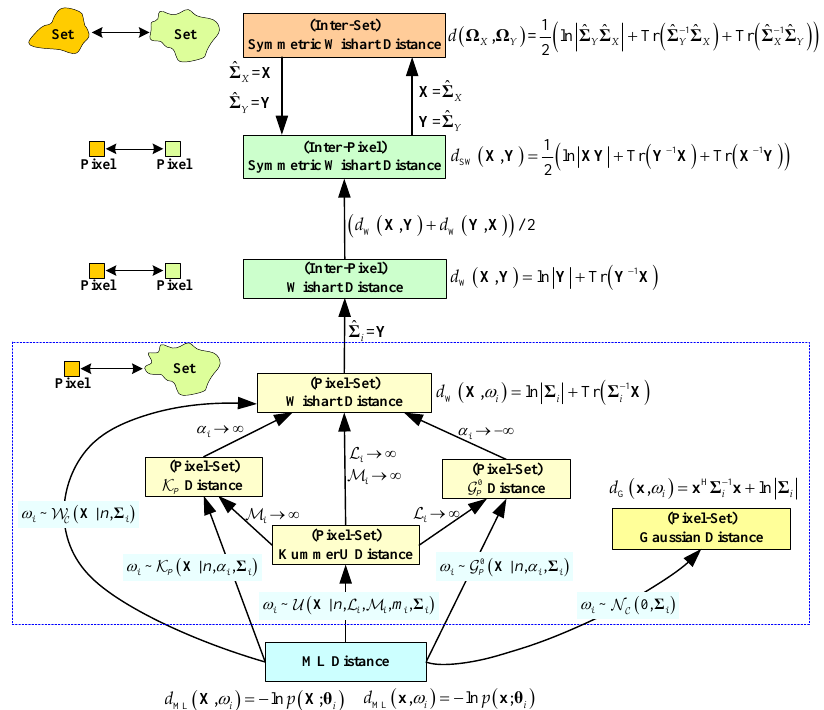
Figure 5. Relations between different ML distances for PolSAR image data.